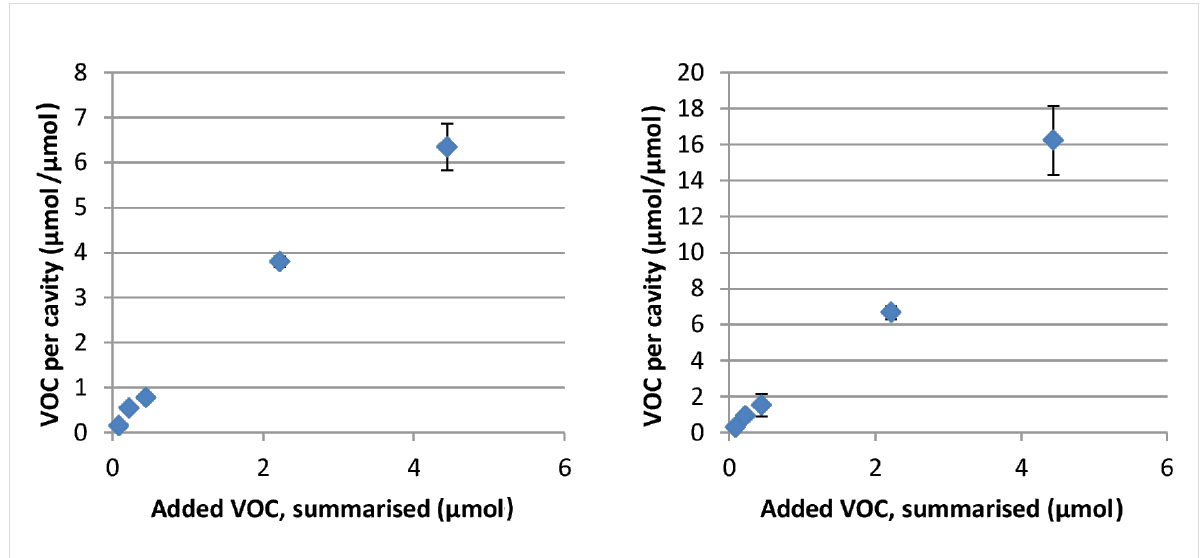
Figure 2: Results of titration experiment for 8 (left) and 10c (right). Standard deviation ( n = 3) indicated with error bars.